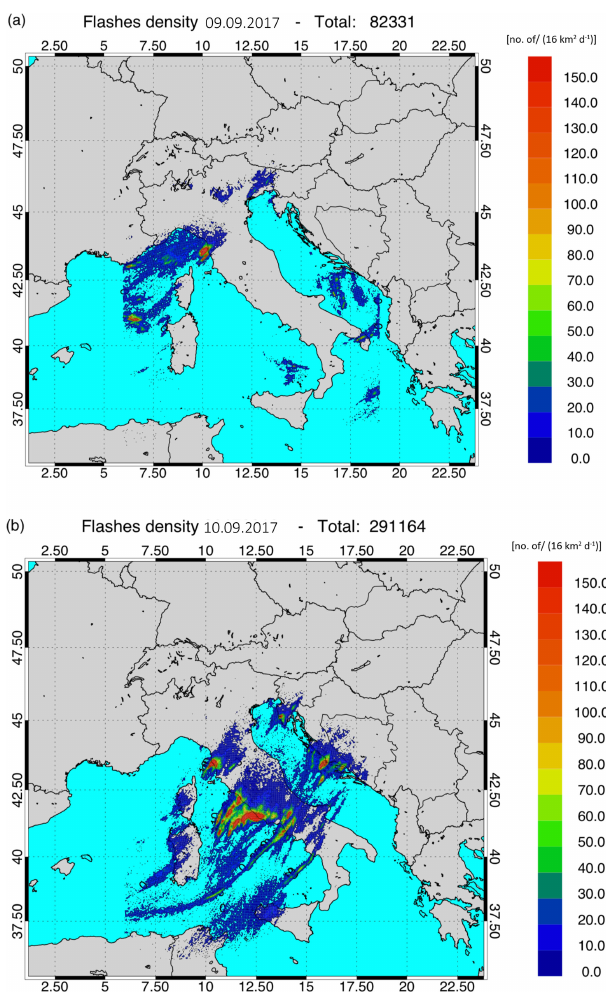
Figure 8. (a) Lightning density (lightning number per 16km 2 for the whole day) recorded on 9 September 2017; (b) as in (a) for 10 September 2017. The number of flashes on each day is shown in the